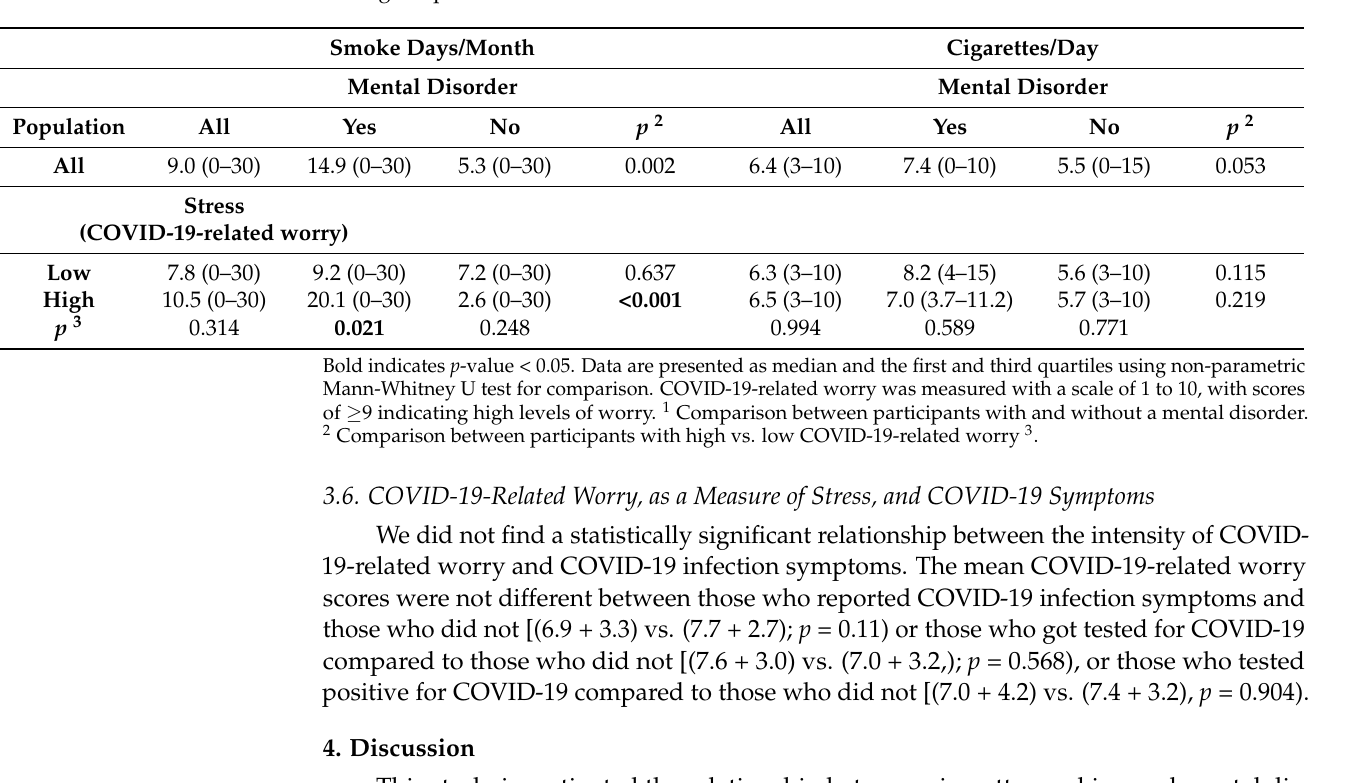
Table 5. Influence of COVID-19-related worry scores, as a measure of stress, on smoking frequency during the pandemic 1